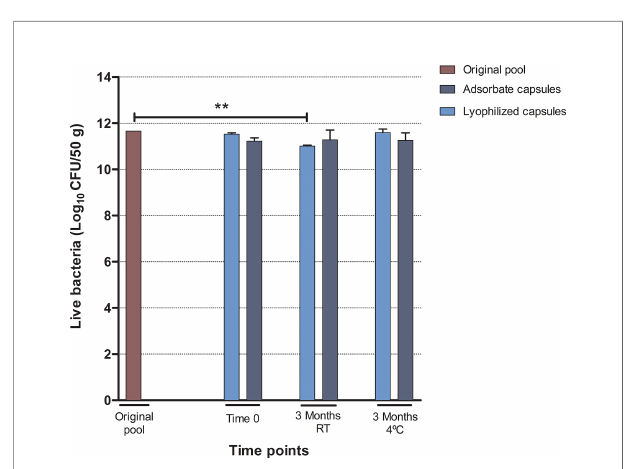
FIGURE 3 | Results from fl ow cytometry analysis corresponding to the number of viable bacteria expressed as the mean of Log 10 CFU/50 g of feces (SD) in each step and after 3 months of storage at room temperature (RT) or 4°C. Statistical signi fi cance **<0.005.